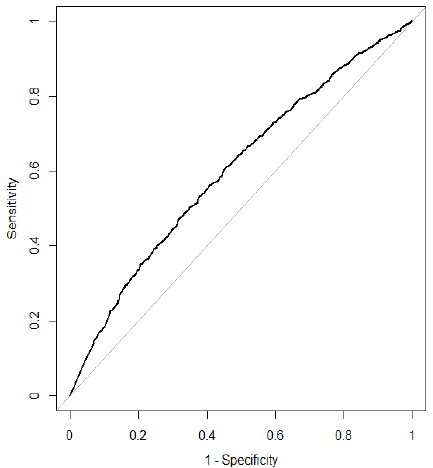
Figure 3. ROC curve for random forest. (AUC = 0.605, F-score = 0.714).